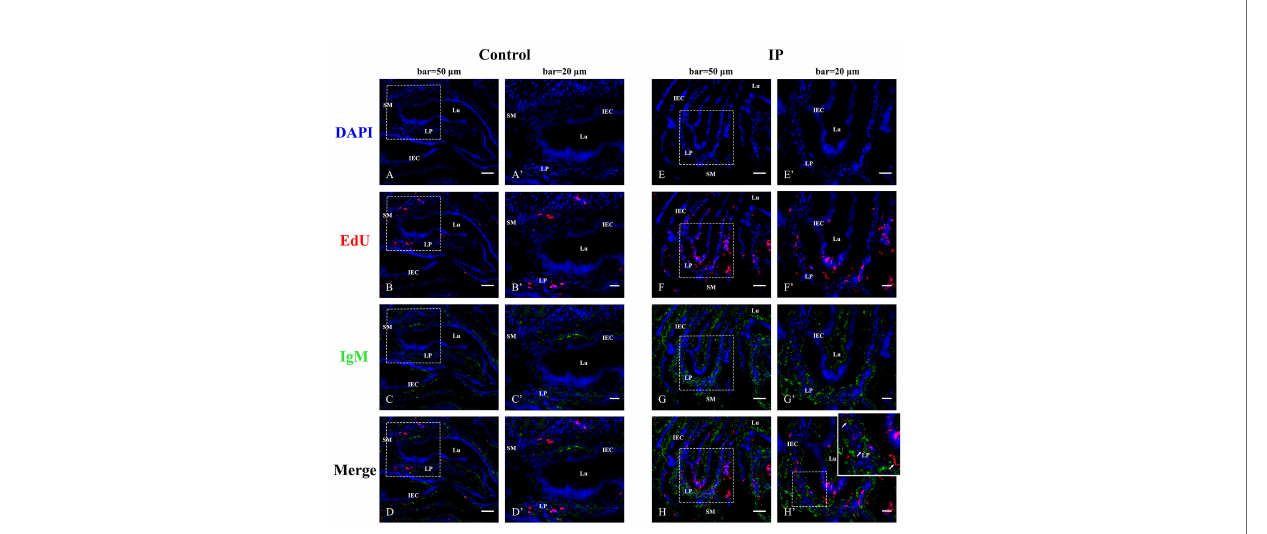
FIGURE 3 | Indirect immuno fl uorescence for co-localization of EdU and IgM in fl ounder hindgut. The cell nuclei were counterstained in blue with DAPI. (A – D) The distribution of EdU and IgM in the PBS-control group at 48 h after EdU injection. Bar = 50 µm. (A ′ – D ′ ) The higher magni fi cation view of the insert area (white box) in (A – D) , respectively. Bar = 20 µm. (E – H) The distribution of EdU and IgM in the group intraperitoneally (IP) injected with EdU for 48 h after 7 days of intraperitoneal injection with inactivated Vibrio anguillarum. Bar = 50 µm. (E ′ – H ′ ) The higher magni fi cation view of the insert area (white box) in (E – H) , respectively. Bar = 20 µm. LP, lamina propria; Lu, lumen; IECs, intestinal epithelial cells; SM,